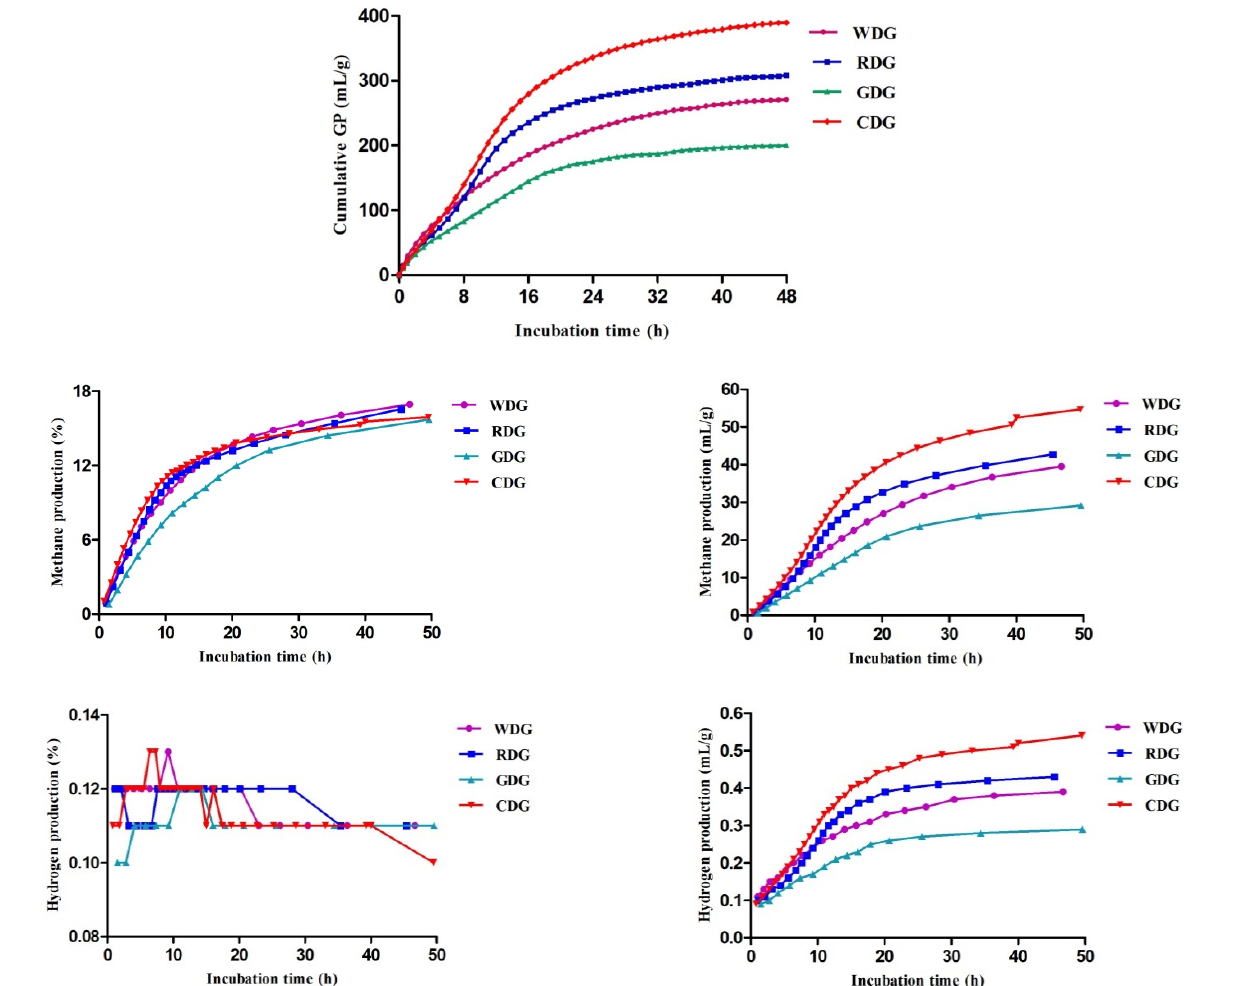
Figure 2. The total gas, methane and hydrogen production of four types of distiller’s grains. WDG = white distiller’s grains, RDG = red distiller’s grains, GDG = glutinous rice distiller’s grains, CDG = corn distiller’s grains. Data reported as least-squares means ± SD. Table 2. Fermentation kinetics and degradability of four types of distiller’s grains.